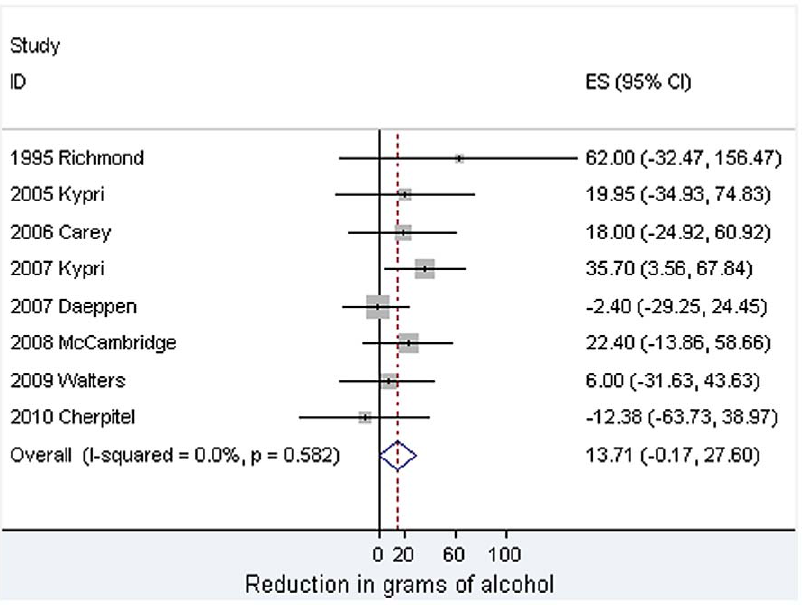
Figure 2. Meta-analysis of the effects of answering questions on total weekly drinking.